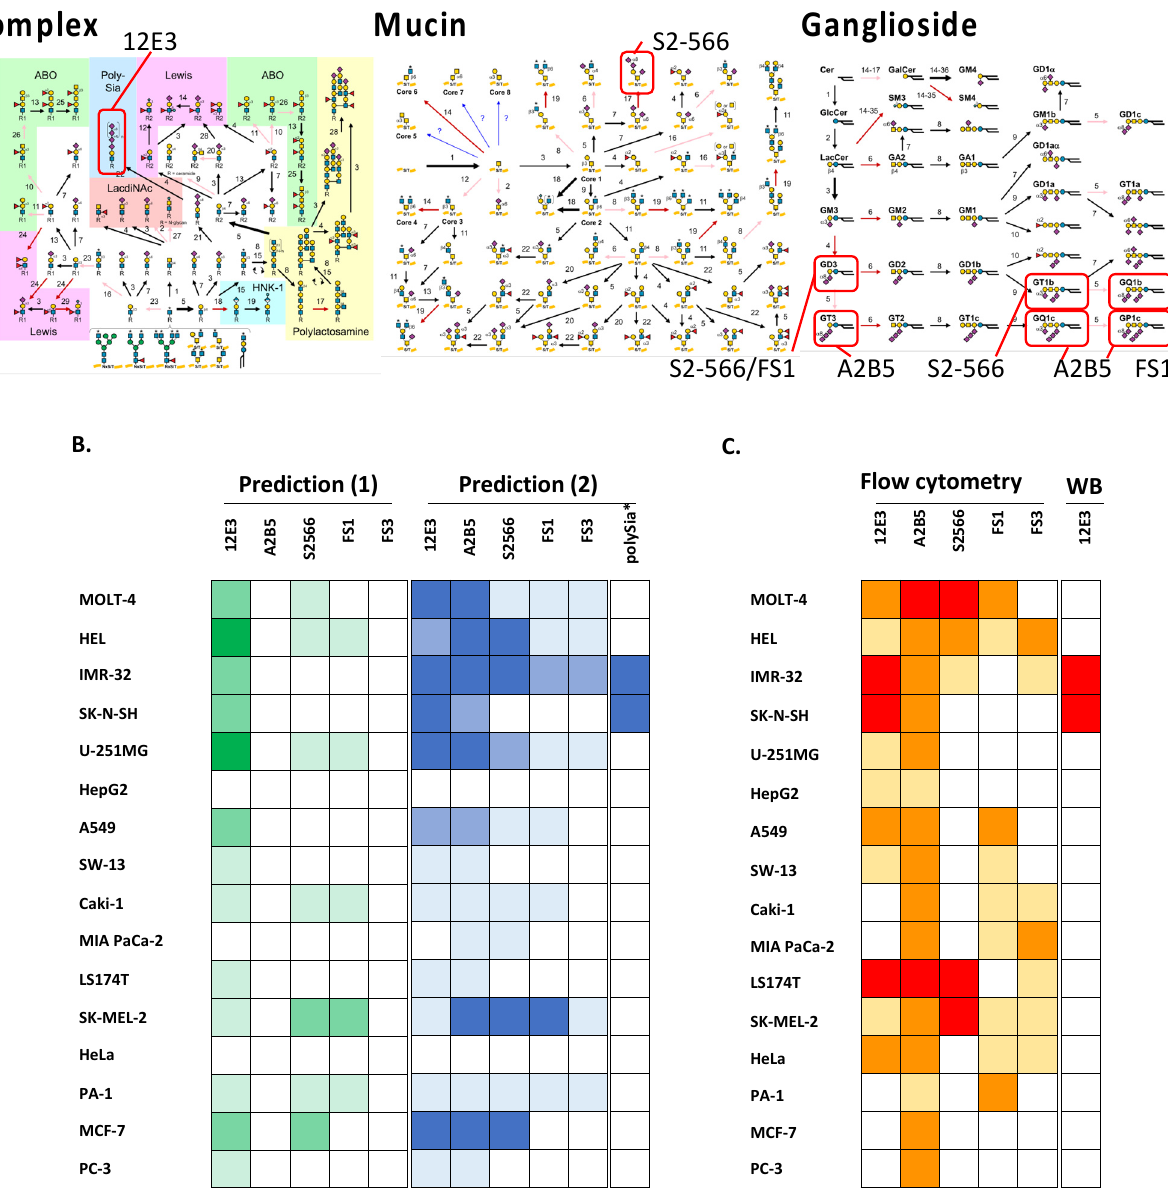
Figure 4. Validation of the results obtained by the dry and wet analyses. ( A ) Epitope structures recognized by the anti-sialoglycoconjugates antibody used in this study. Combinations of the antibody with its epitope structure (red square) are indicated on the pathway maps for the complex N- glycan, mucin, and ganglioside. ( B ) Expression patterns of oligo/polySia structures predicted by (1) the Glycomaple method and (2) our method (Figure 1). ( C ) Expression patterns of oligo/polySia structures observed by the flow cytometry analysis and Western blotting. For B and C, dark color, high expression; light color, low expression; white, no expression .